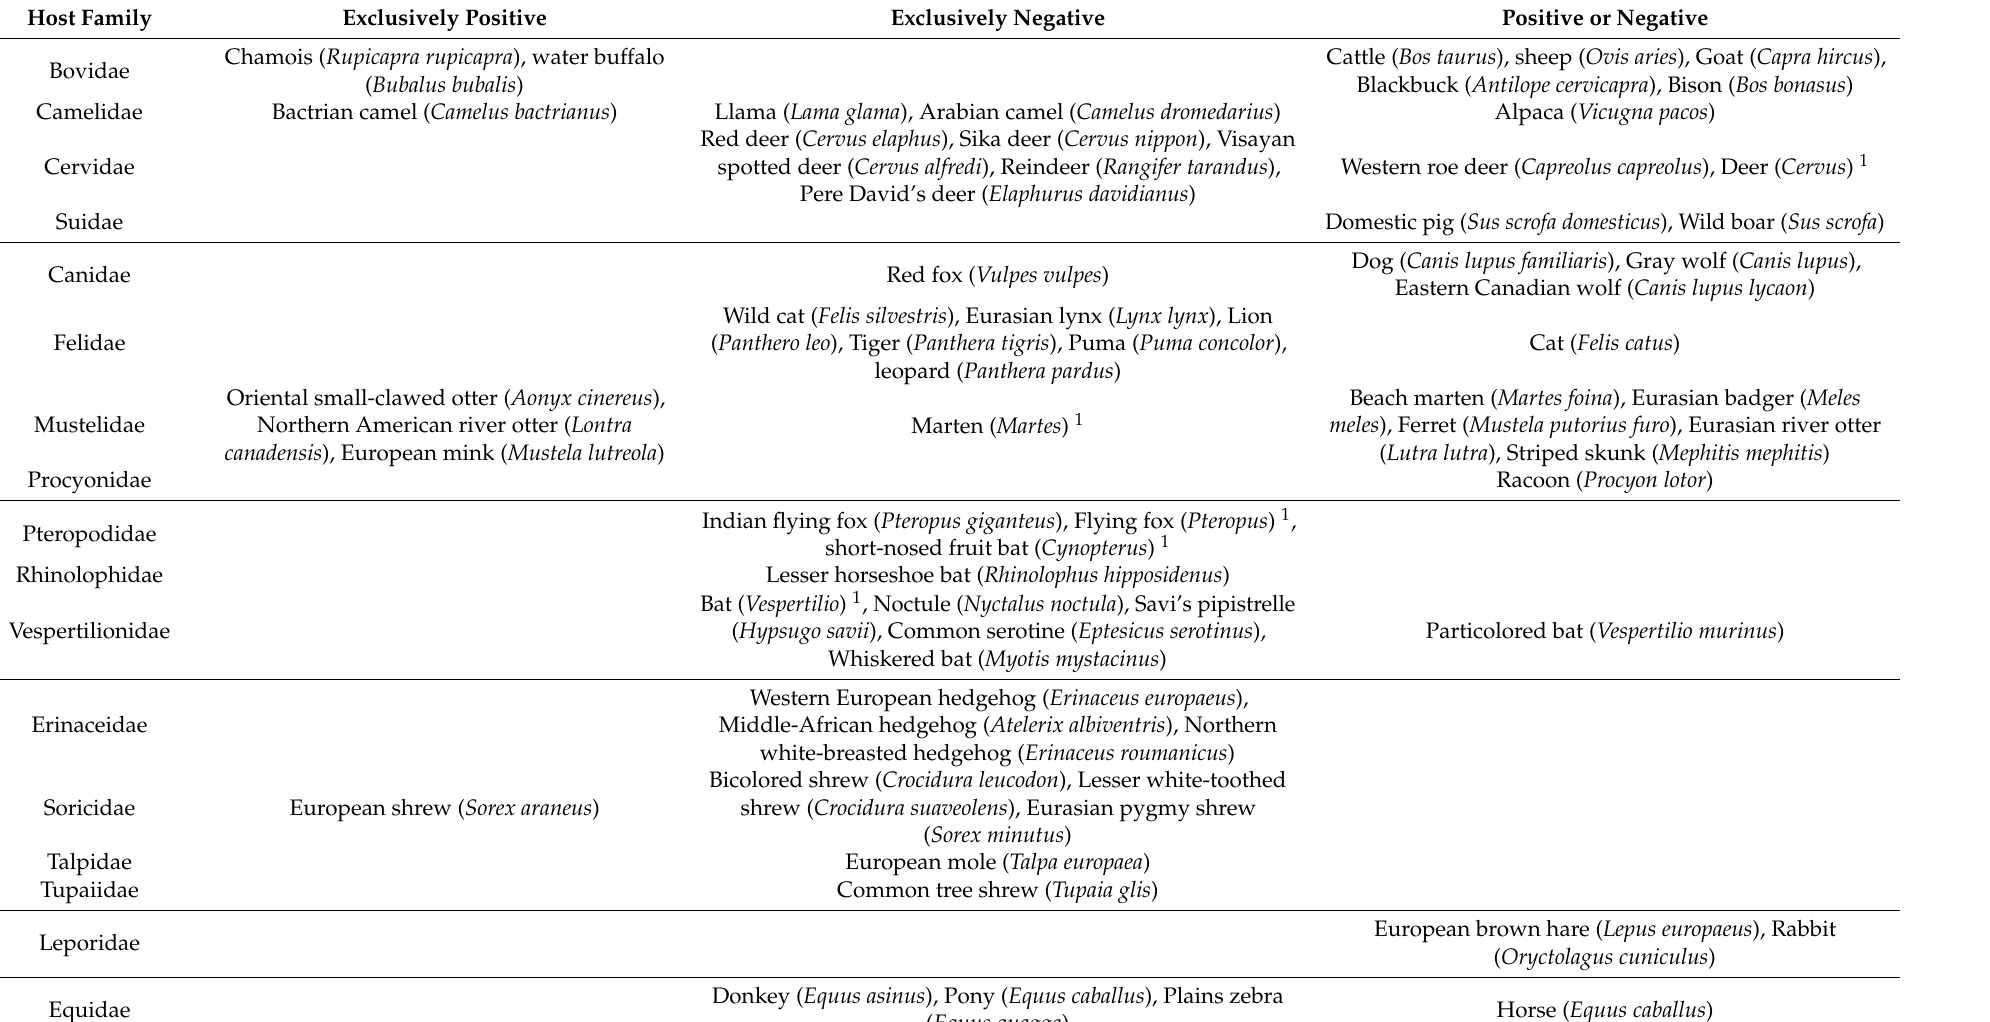
Table 2. Mammal species found either exclusively positive, negative, or positive/negative for Pneumocystis spp. by